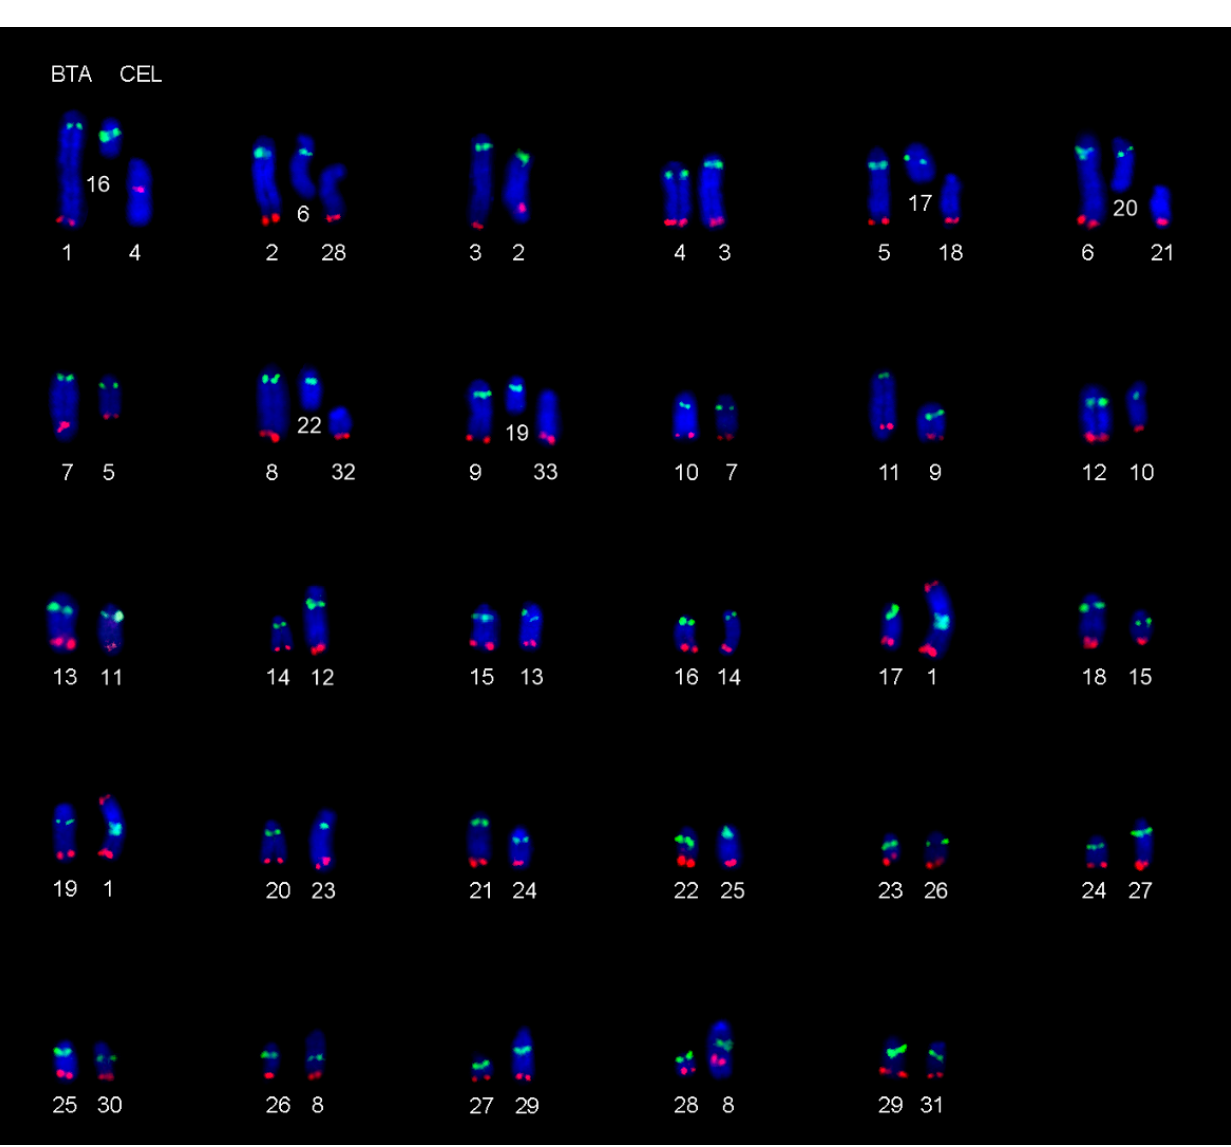
Figure 2. Centromere-telomere orientation of orthologous bovine ( B. taurus , BTA) and red deer ( C. elaphus , CEL) chromo- somes confirmed by BAC-FISH. Green signal—proximal BAC probe; red signal—distal BAC probe. Table 2. CerEla1.0 and ARS-UCD1.2 genome assembly comparisons.